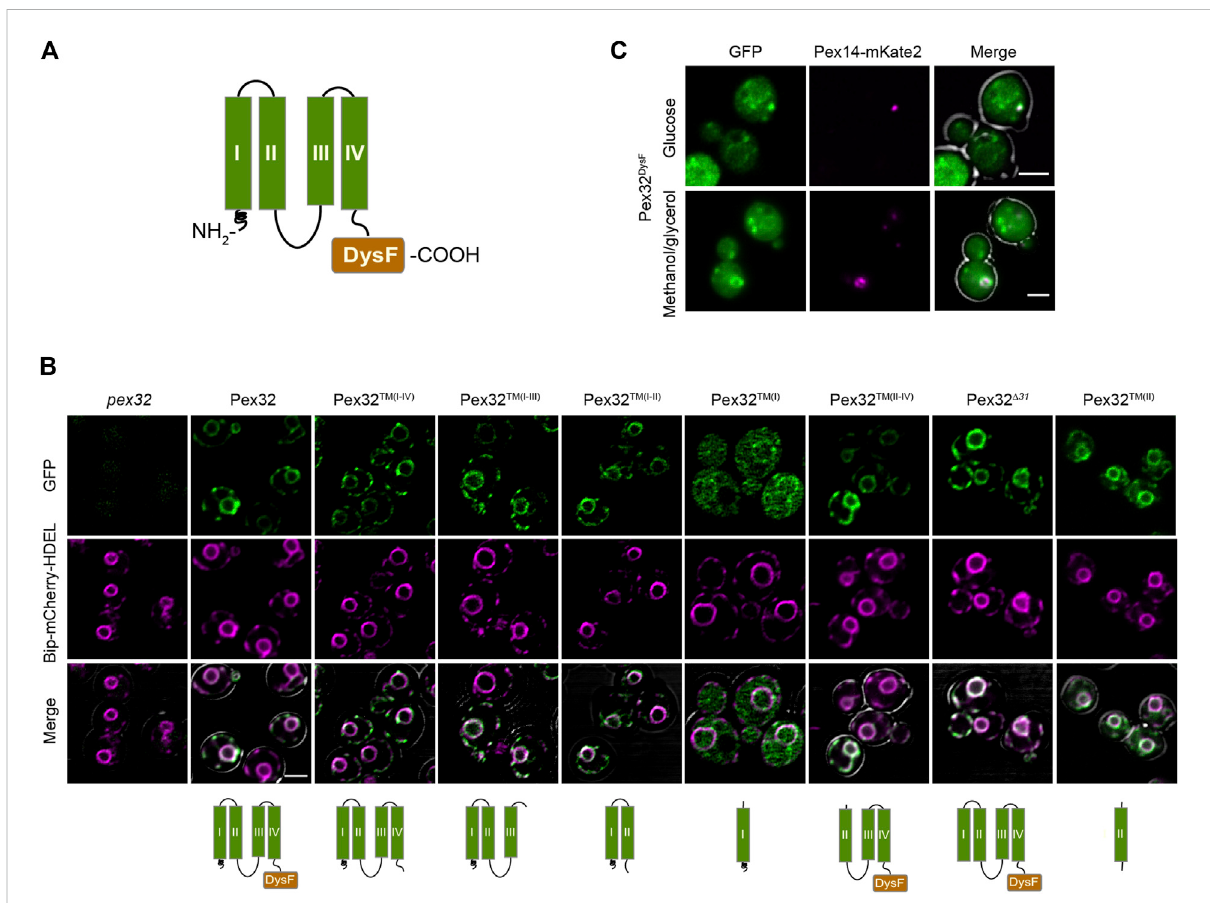
Pex32 TM helices contain ER sorting information, while the DysF domain has the capacity to associate with peroxisomes. (A) Predicted Pex32 structure. Transmembrane helixes (TMs) are numbered I, II, III and IV. (B) Confocal Laser Scanning Microscopy (CLSM) Airy-scan analysis of glucose-grown pex32 cells producing the ER marker Bip-mCherry-HDEL and the indicated Pex32 truncations fused to GFP and produced under control of the PADH1. Images were processed differently, in order to visualize the GFP signal optimally. Scale bars: 2 μ m. (C) CLSM Airy-scan images of glucose-grown cells (top) and fl uorescence microscopy (FM) images of methanol/glycerol-grown pex32 cells producing Pex14-mKate2 and PADH1Pex32DysF-mGFP (bottom). Scale bars: 2 μ